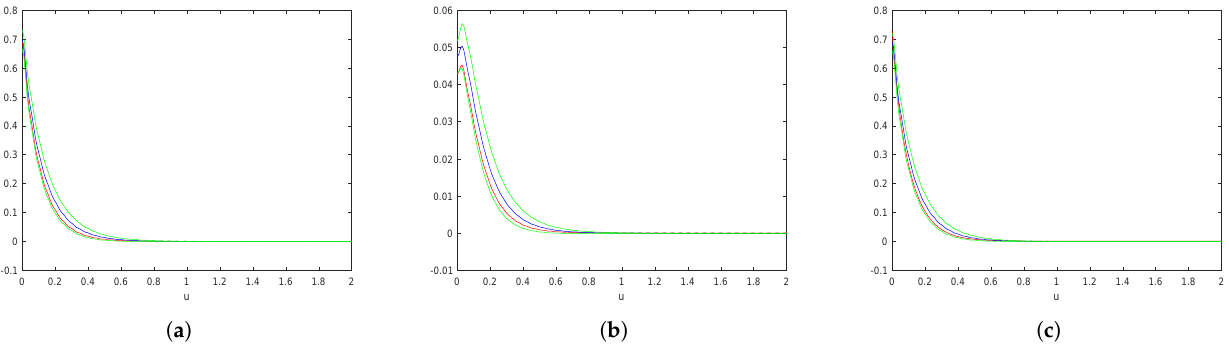
Figure 6. For the Lévy-Gamma risk model, we plot the confidence band curves (green curves), mean value curves (blue curves) and reference value curves (red curves). ( a ) Ruin probability; ( b ) Expected claim size causing ruin; ( c ) Laplace transform of ruin